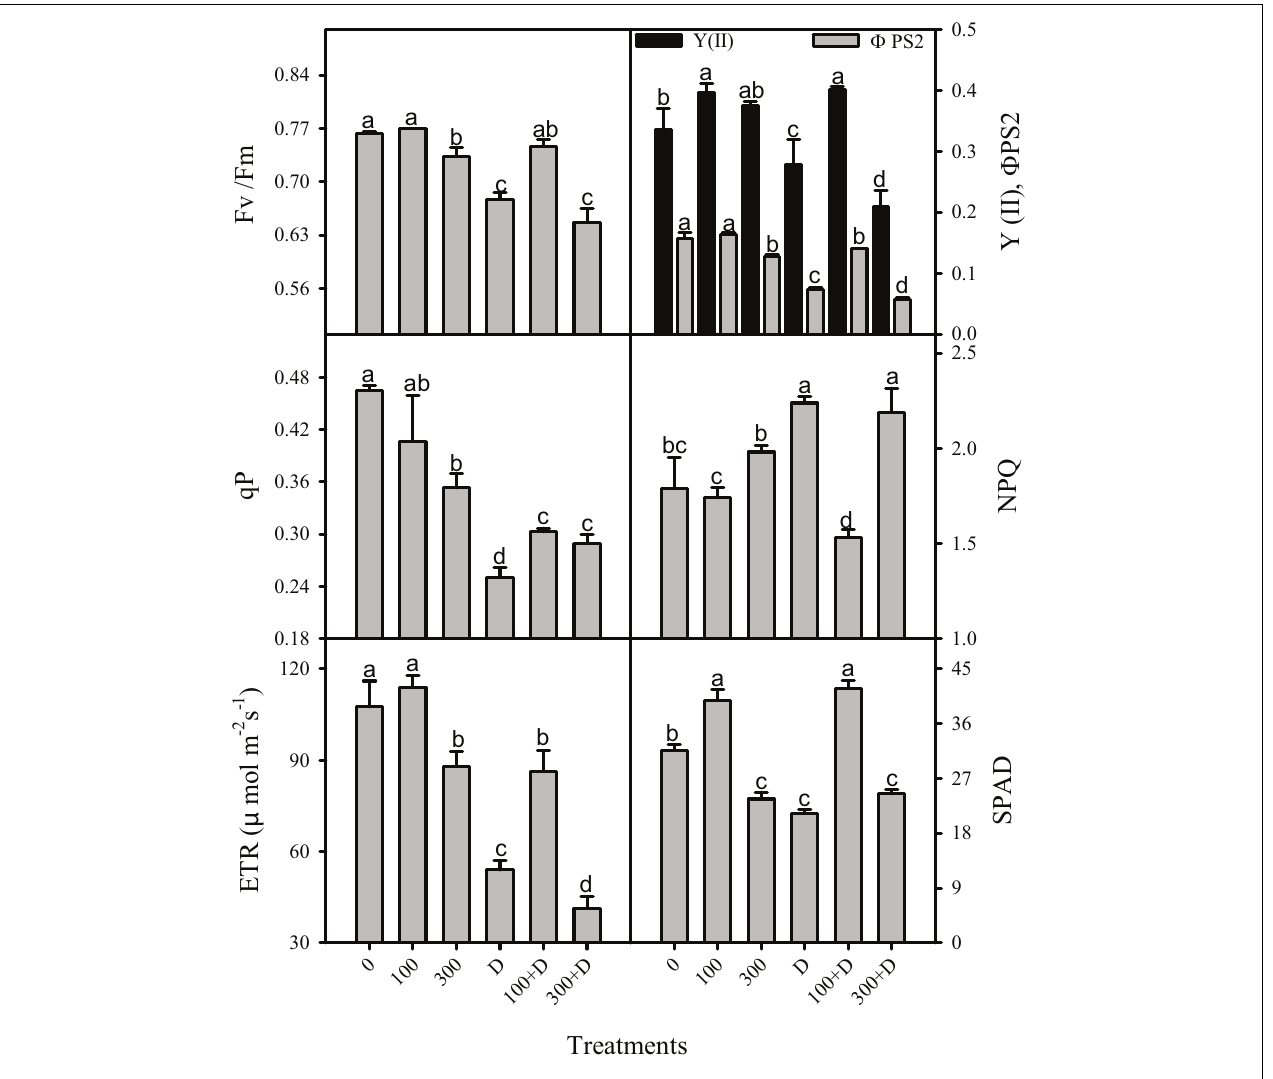
FIGURE 7 | Responses of chlorophyll a fluorescence in the leaf of Panicum antidotale under salinity, drought, and a combination of both treatments. The mean ± SE ( n = 3), maximum quantum efficiency of PS2 ( F v / F m ), apparent quantum efficiency of PS2 ( (cid:56) PS2, YII), photochemical quenching (qP), non-photochemical quenching (NPQ), electron transport rate (ETR), and chlorophyll (SPAD) for treatments of 0, 100, and 300 mM NaCl, drought (D), and a combination of salinity with drought [100 and 300 mM NaCl + drought (100 + D and 300 + D, respectively)] are shown. Different letters denote, after Bonferroni post hoc test, significant difference ( P <